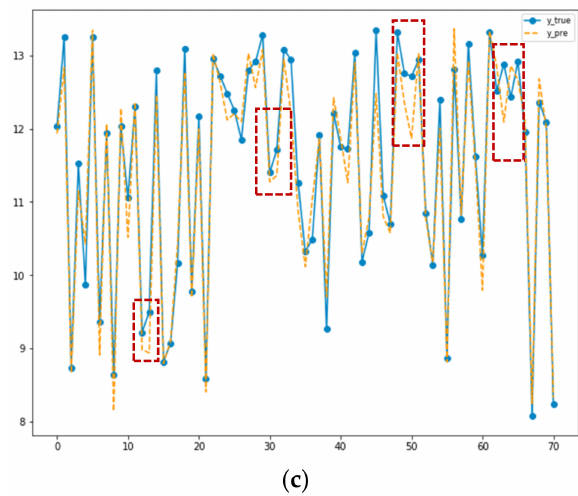
Figure 6. Fitting effect of different models on test datasets: ( a ) fitting effect of WT_TDLSTM model on residential monthly electricity price test dataset; ( b ) fitting effect of LSTM_NN model on commercial monthly electricity price test dataset; ( c ) fitting effect of LSTM model on industrial monthly electricity price test dataset. The solid line and the dashed line refer to the true value and the predicted value, respectively.